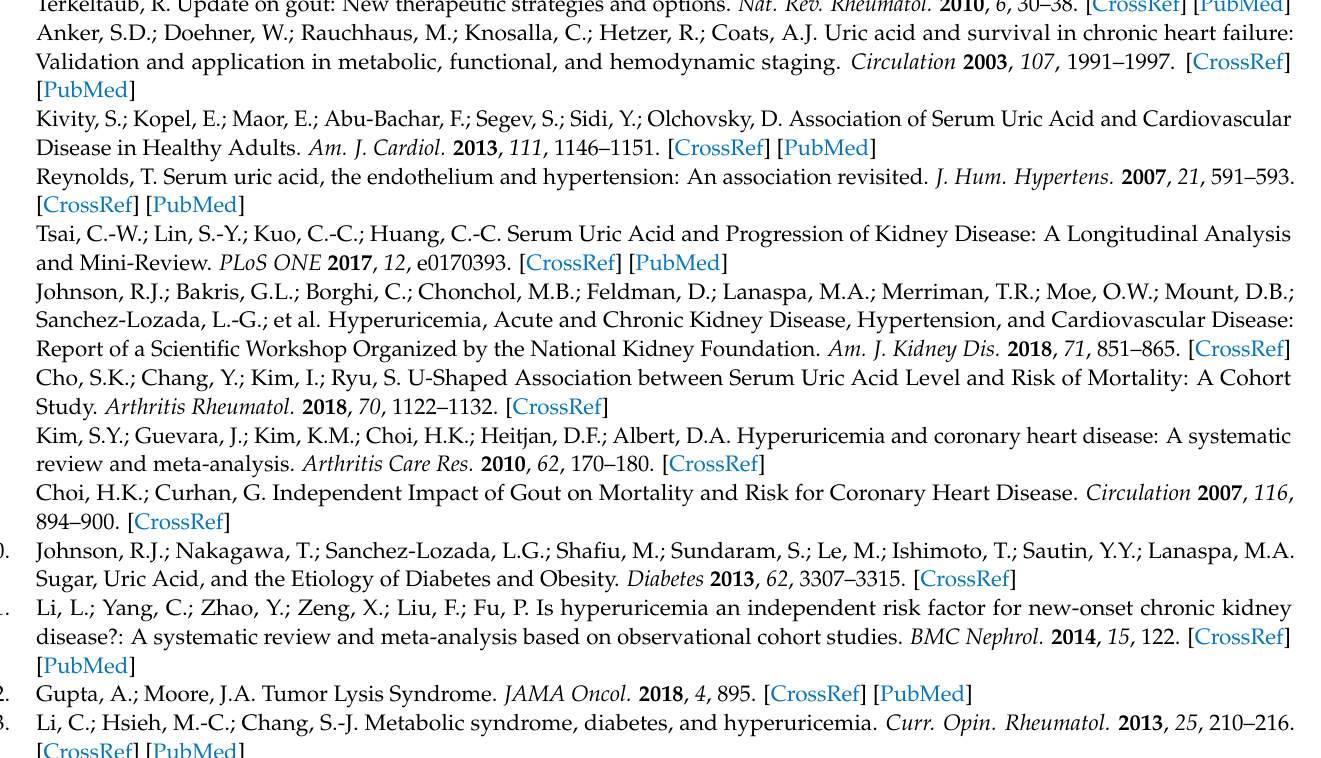
Figure S3: Forest plot of SUA-lowering effect of topiroxostat [49,50,63,71–74]; Figure S4: Funnel plot of AD for febuxostat monotherapy vs. allopurinol 300 mg daily [42–45]; Table S1: Exclusion of the Trial Arms in the Urate-Lowering Therapy Drug